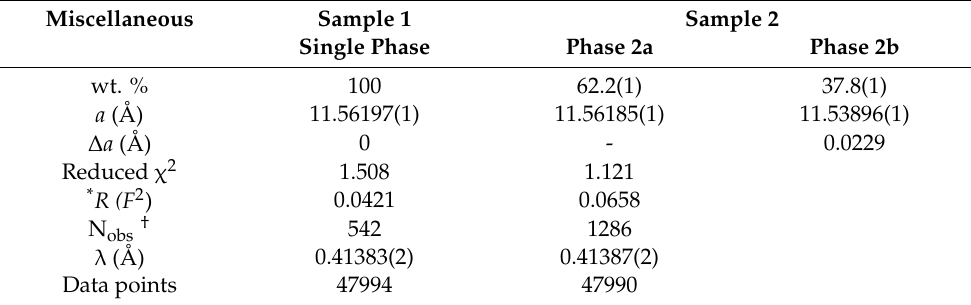
Table 2. HRPXRD data and Rietveld refinement statistics for two pyrope